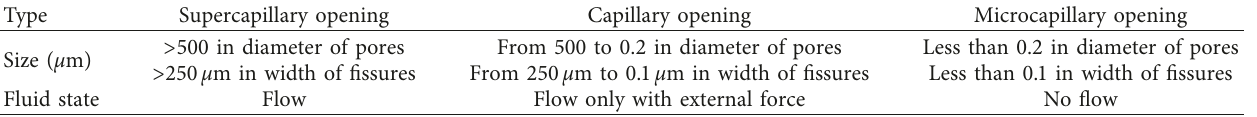
Table 1: Pore classification based on the contribution to fluid percolation.